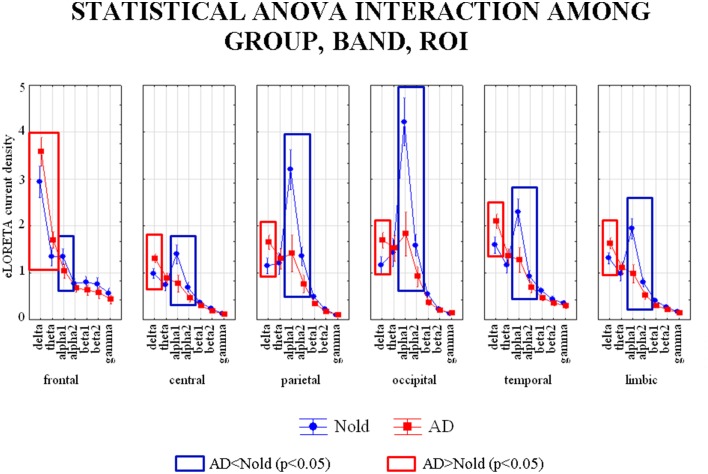
Diagram showing the grand average of regional normalized exact low-resolution brain electromagnetic tomography (eLORETA) solutions (i.e., source activity) relative to a statistically significant ANOVA interaction [F(30, 6540) = 18.727, p < 0.0001] among the factors Group (AD, Nold), Band (delta, theta, alpha 1, alpha 2, beta 1, beta 2, gamma), and ROI (central, frontal, parietal, occipital, temporal, limbic). Subjects' age, education, IAF, and gender were used as covariates. Legend: the rectangles indicate the cortical regions and frequency bands in which source activity presented the statistically significant LORETA pattern of source activity Nold ≠ AD (Duncan test, p < 0.05).